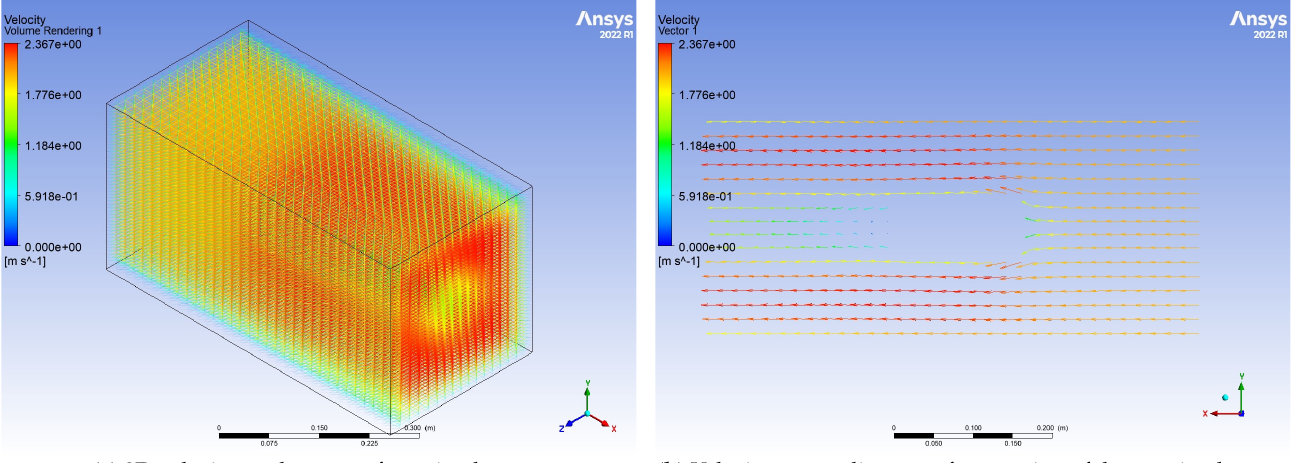
Figure 18. Three-dimensional velocity nephogram of r = 0, v = 1 freezer and x-y plane velocity vector Figure 18. Three ‐ dimensional velocity nephogram of r = 0, v = 1 freezer and x ‐ y plane velocity vector diagram of freezer. diagram of freezer.